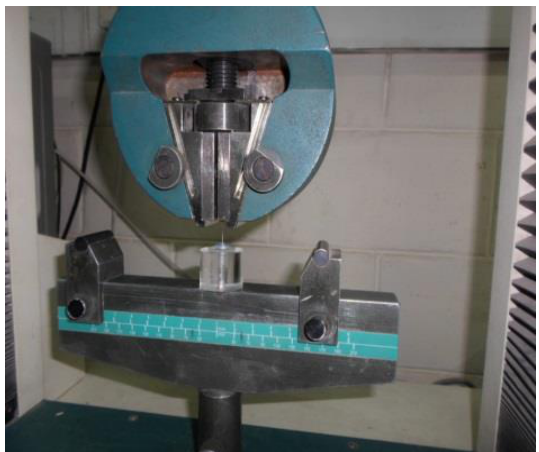
Figure 1: Length of tooth was measured with